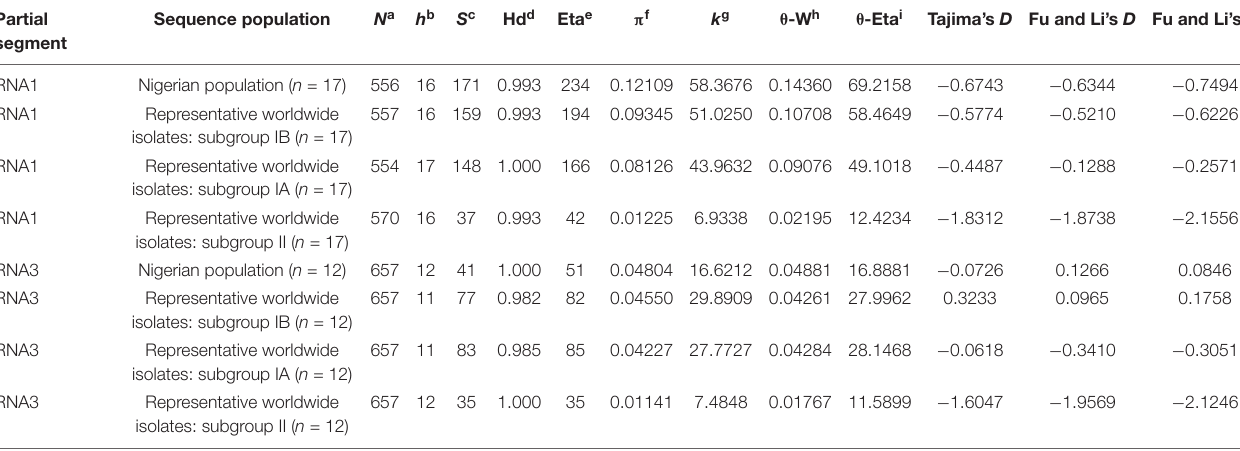
TABLE 6 | Estimation of population genetic parameters for partial CMV RNA1 and RNA3 sequences from Nigeria in comparison with other worldwide strains. Partial segment